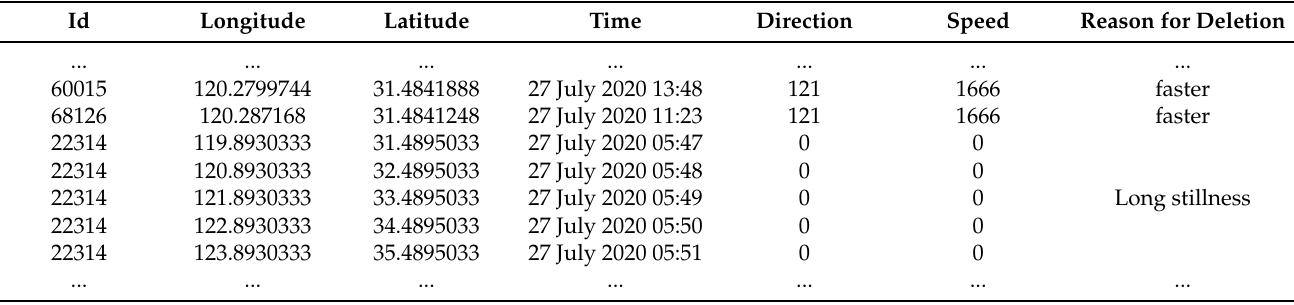
Figure 5. The process of data collaboration. Firstly, the original GPS data are judged to delete the abnormal data and retain the normal data. Then, the spatiotemporal distribution features were mined to extract travel hotspots and peak hours. Next, for hot intersections, UAV is used to collect traffic flow data during peak hours, and the UAV video data are processed and analyzed to mine traffic flow and capture behaviour characteristics. Finally, UE4 is used to visually model the digital twin of the target intersection. Table 2. Partial filtered data and reasons for